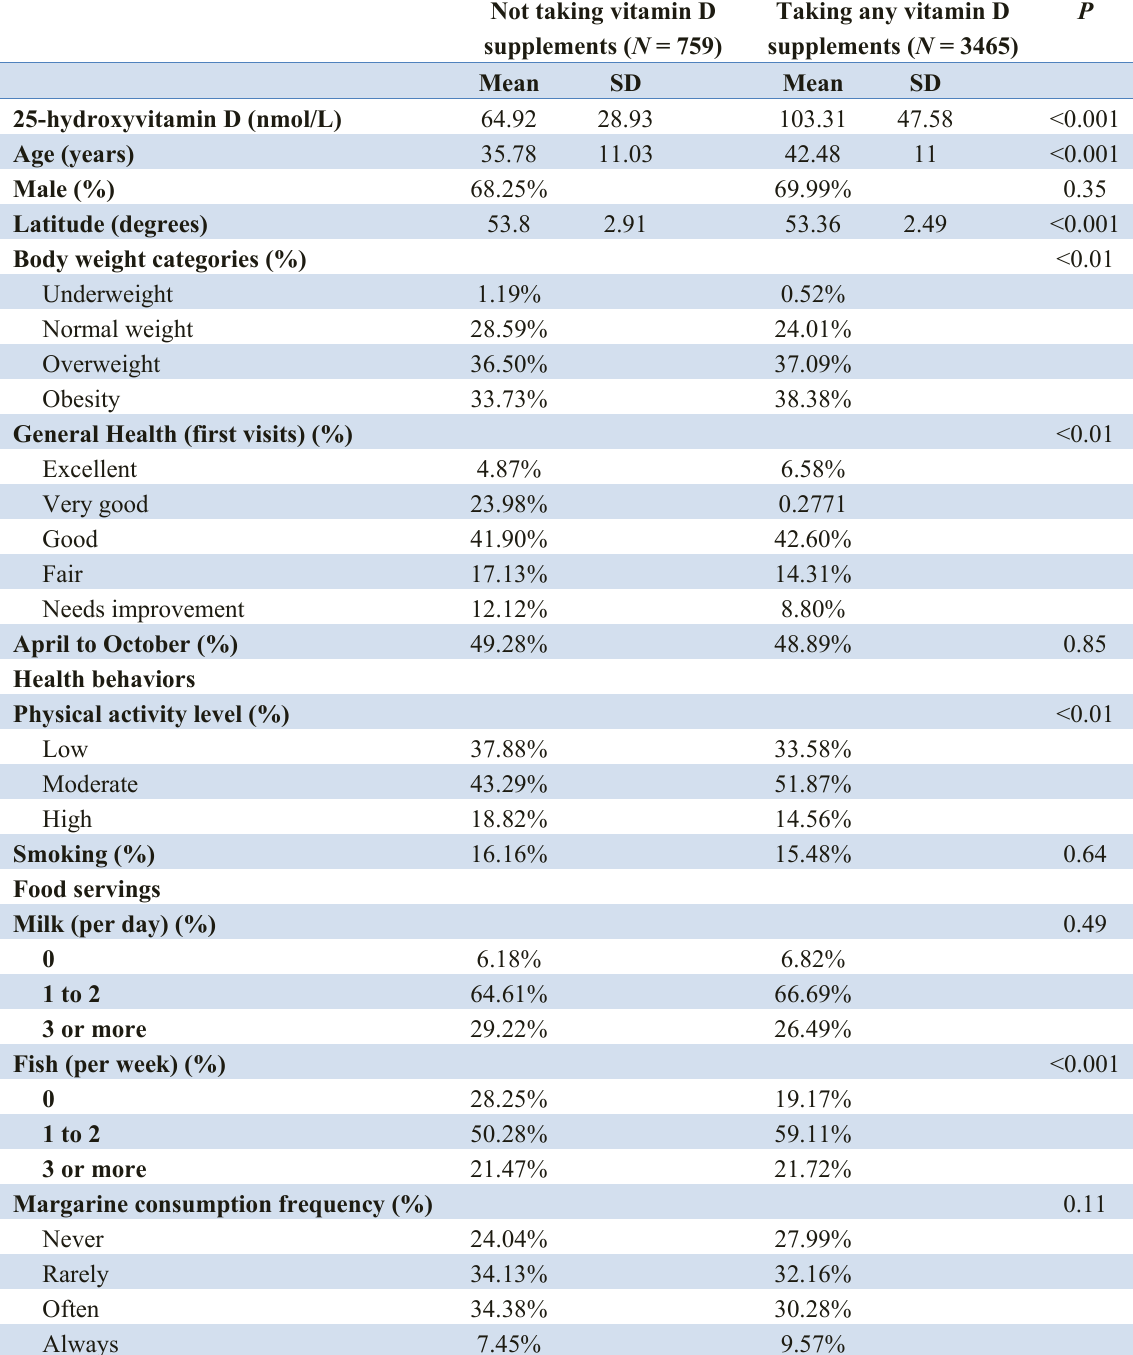
Table 1. Characteristics of 4224 visits by 2714 participants according to vitamin D supplementation